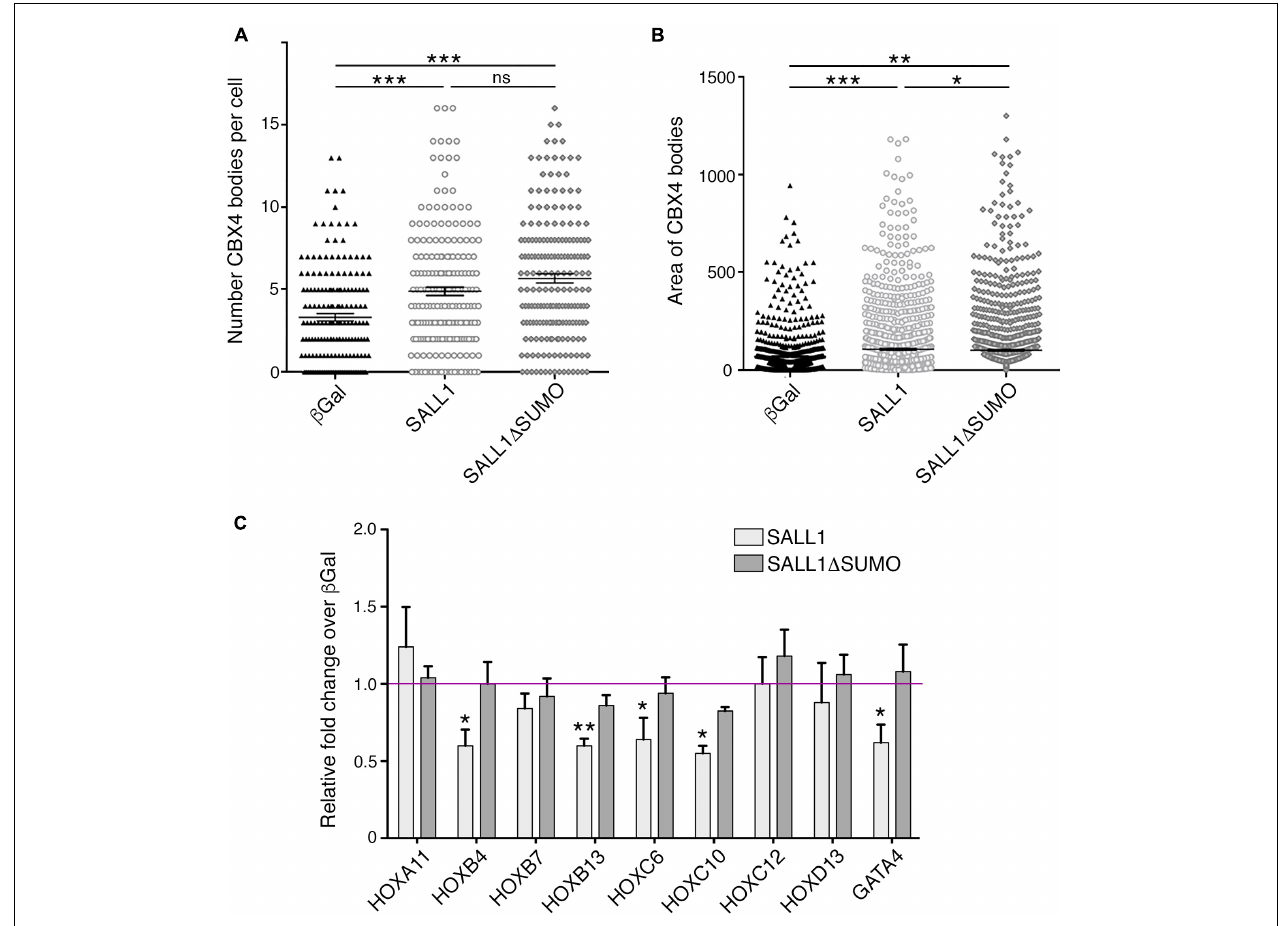
FIGURE 7 | SALL1 expression increases the number and size of CBX4-containing Pc bodies and enhances downregulation of CBX4 targets. (A,B) Graphs represent the number of CBX4-containing Pc bodies (A) and their mean area in pixels quantified using Fiji software (B) in U2OS cells expressing SALL1-YFP, SALL1 (cid:49) SUMO-YFP, or GFP- β -gal as a negative control. (C) Graph showing the mRNA expression levels of several CBX4 target genes in HEK 293FT cells expressing SALL1-YFP, SALL1 (cid:49) SUMO-YFP, or GFP- β -gal as control. Data shown correspond to the mean plus SEM of at least five independent RT-qPCR experiments. Gene expression data were normalized to GAPDH and are shown as relative fold change over β -Gal expressing cells (magenta line). P -values were calculated using one-way ANOVA test. * P -value < 0.05; ** P -value < 0.01; *** P -value < 0.001.